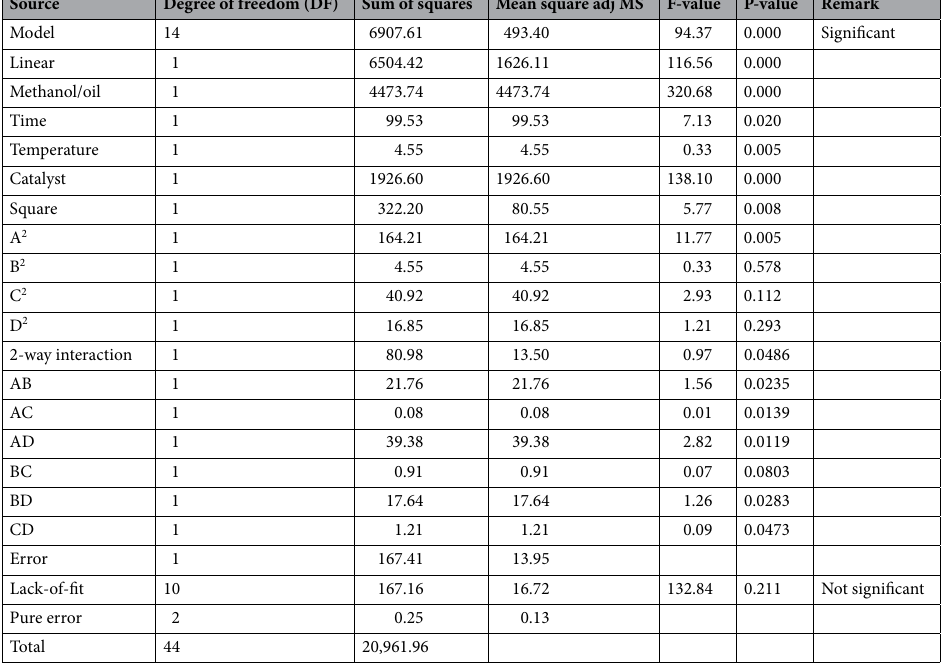
Table 4. ANOVA of the proposed model for FAME production. R 2 = 0.9763, R 2 (adjusted) = 0.9754, R